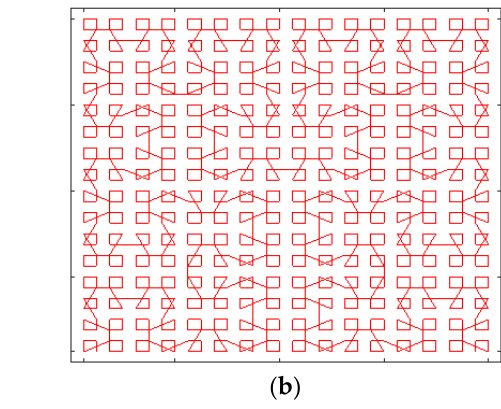
Figure 7. Two 5th-order Hilbert curves with different initial curves, ( a ) curve (1), ( b ) curve (5).